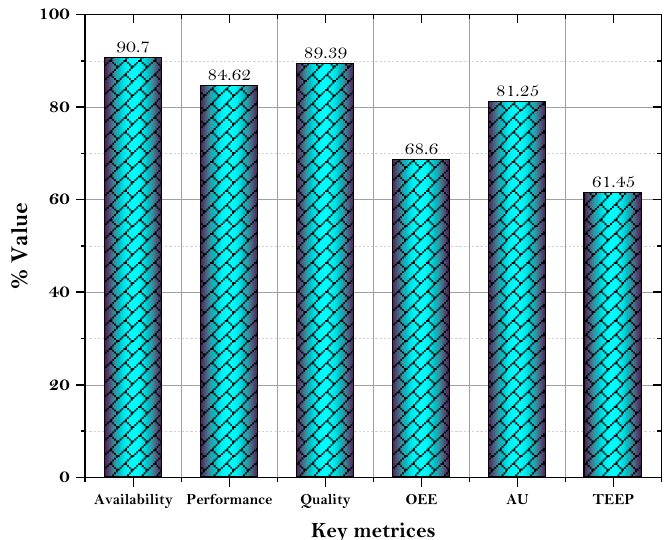
Figure 3. Performance value of key parameters. J. Open Innov. Technol. Mark. Complex. 2021 , 7 , x FOR PEER REVIEW